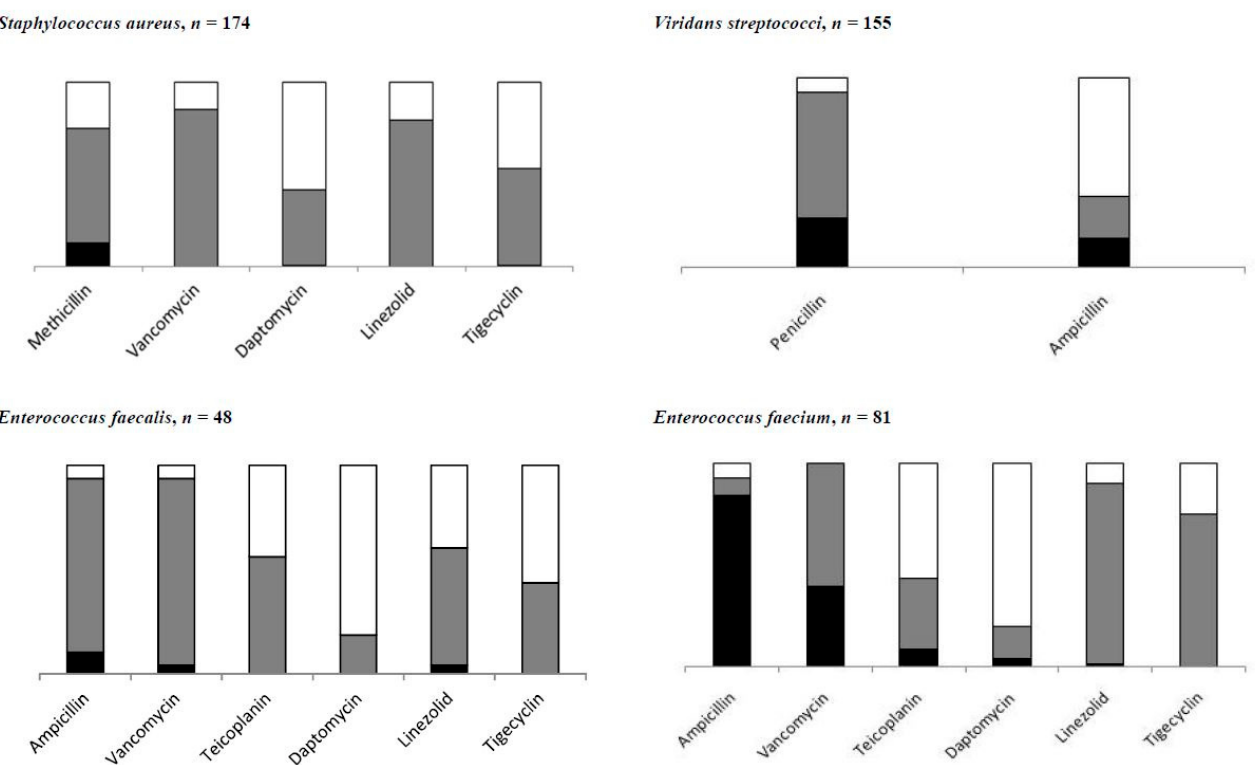
Figure 2. Distribution of resistant antibiotic infections by pathogen type (details in Supplementary Table S3) of Gram-positive. Black box represents percentages of resistant antibiotic infections, gray box of susceptible antibiotic infections, and white box for antibiotic infections not tested.